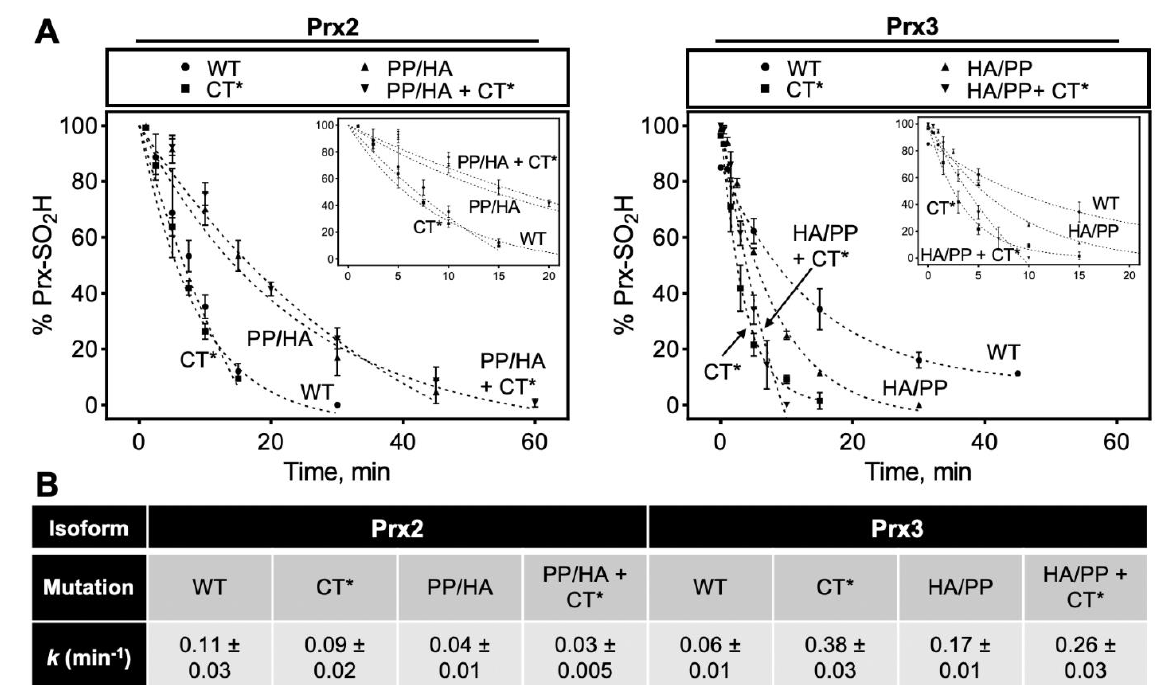
Figure 5. Repair of hyperoxidized Prx2, Prx3 and their chimeras. Time course analysis of Prx-SO 2 H reduction catalyzed by Srx in the presence of DTT. ( A ) The reaction progress was assessed at the indicated time points by ESI-TOF MS analysis and the data represent Prx-SO 2 H signal abundance as a percent of the total ion abundance accounting for all prominent species in the mass spectra ( n = 3). Inset indicates the first 20 min of the reaction. The data for the WT and chimera proteins were fit to an exponential decay equation to compare the relative reaction rates for the repair of hyperoxidized proteins. ( B ) Summary table of kinetic repair parameters, k is shown as ± standard deviation